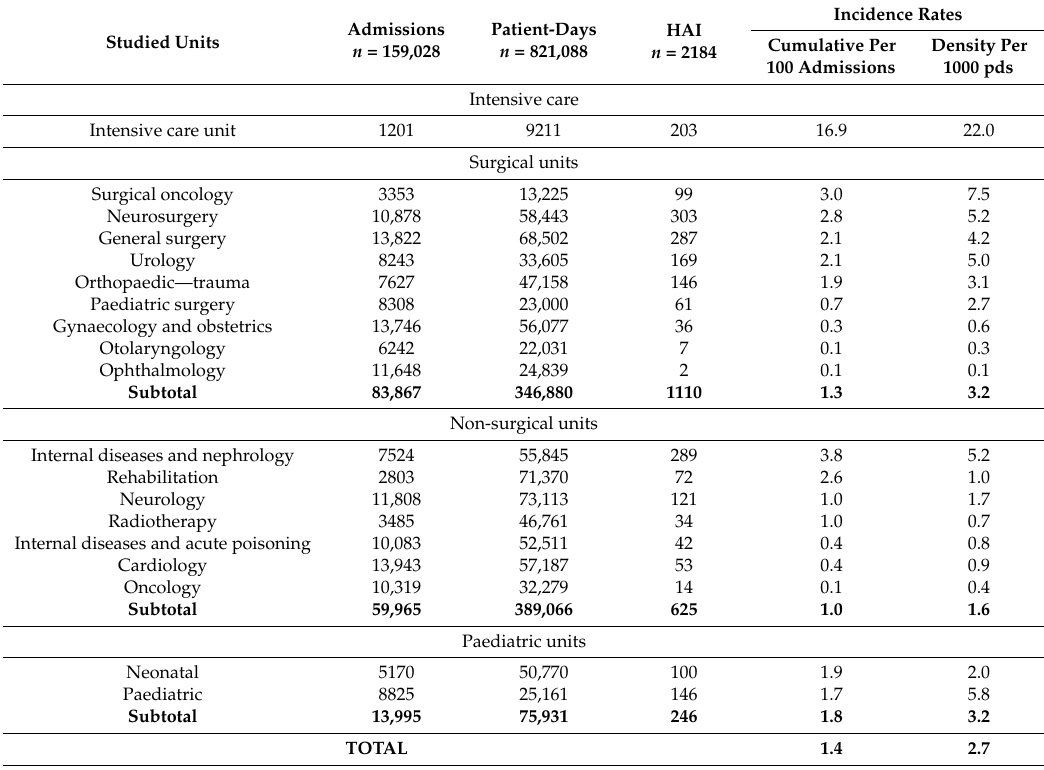
Table 1. Cumulative incidence rates and incidence density rates in different types of hospital units. Studied Units